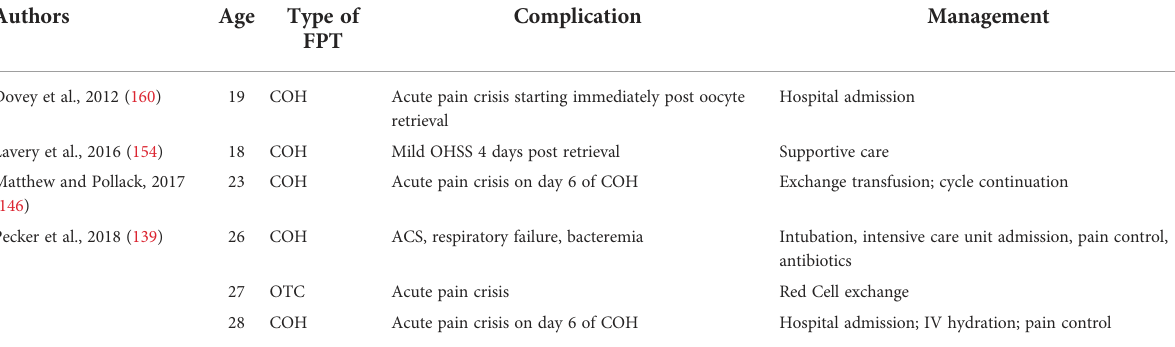
TABLE 5 Adverse outcomes associated with fertility preservation treatment in patients with sickle cell disease.